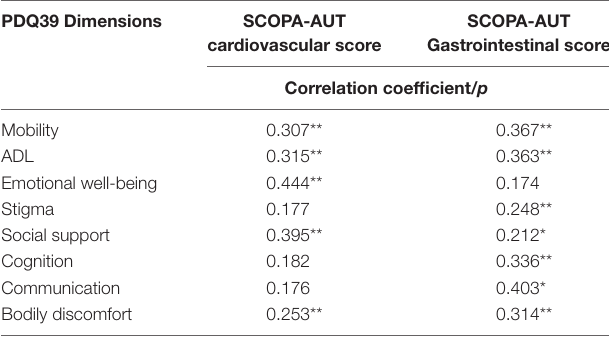
TaBle 7 | Correlation between the PDQ39 dimensions and the most disabling autonomic items gastrointestinal, cardiovascular symptoms.